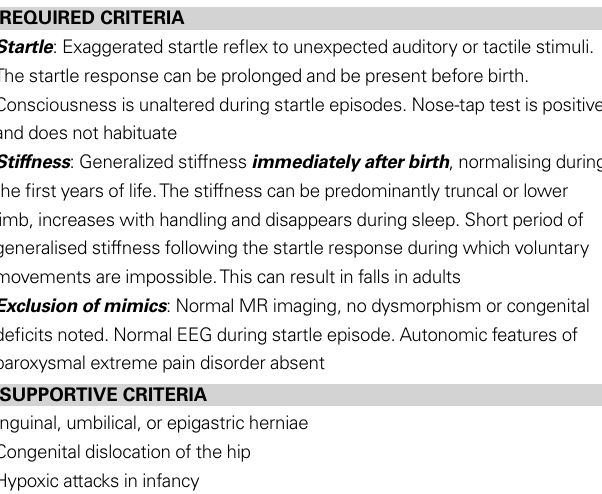
Table 1 | Diagnostic criteria for human hyperekplexia. REQUIRED